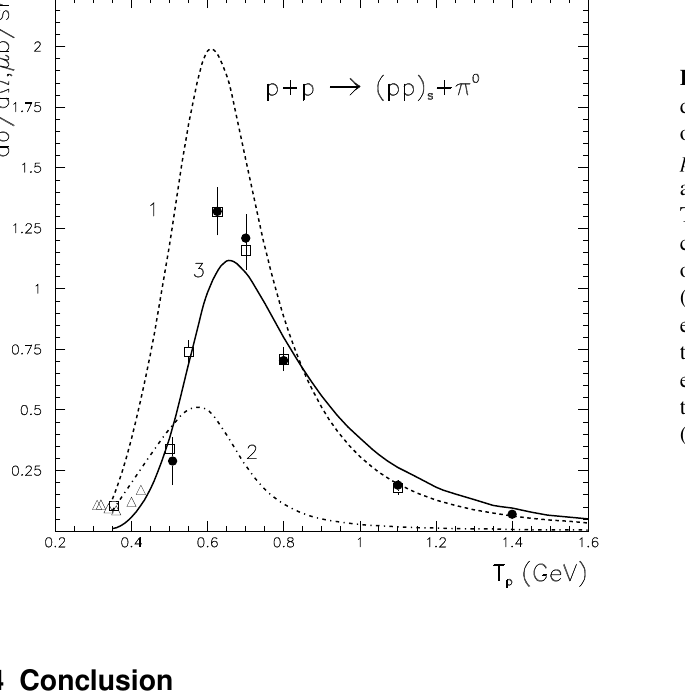
Figure 4. The di ff erential cross section of the reaction pp → { pp } s π 0 at zero angle of the diproton. The lines show results of calculations [15] based on the ∆ -mechanism (Fig. 3) for the direct (1), exchange (2) term and their coherent sum(3); experimental data are taken from [5] ( • ), [6] ( (cid:3) ) and [13] ( (cid:52)